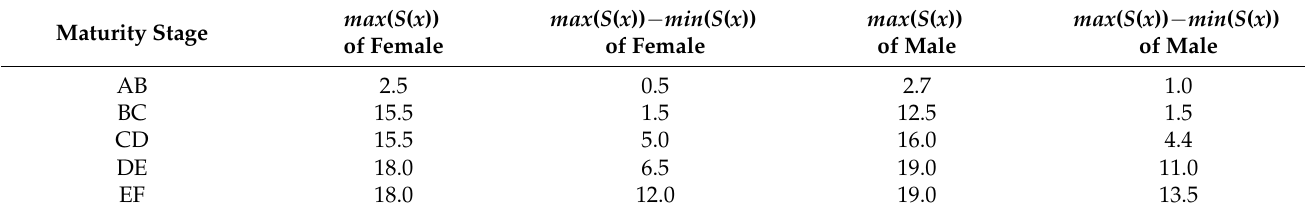
Table 2. Bone age range of each stage.